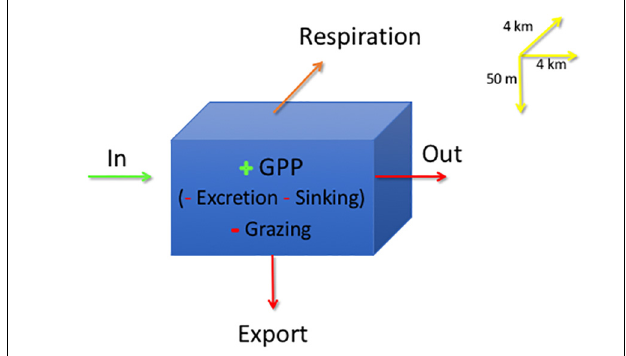
FIGURE 2 | SINMOD model grid cell describing the main phytoplankton processes: Advection is depicted as import (Biomass-IN) and output (Biomass-OUT), Gross Primary Production (GPP), Grazing, Excretion, Respiration and Sinking. Input terms are in green, as g C m − 2 d − 1 and loss terms in red, with the same units. All model output is expressed in units of phytoplankton carbon. The model grid is 4 km × 4 km in x-y and by 50 m in depth. Upstream advection is depicted as Advection-IN and downstream advection by